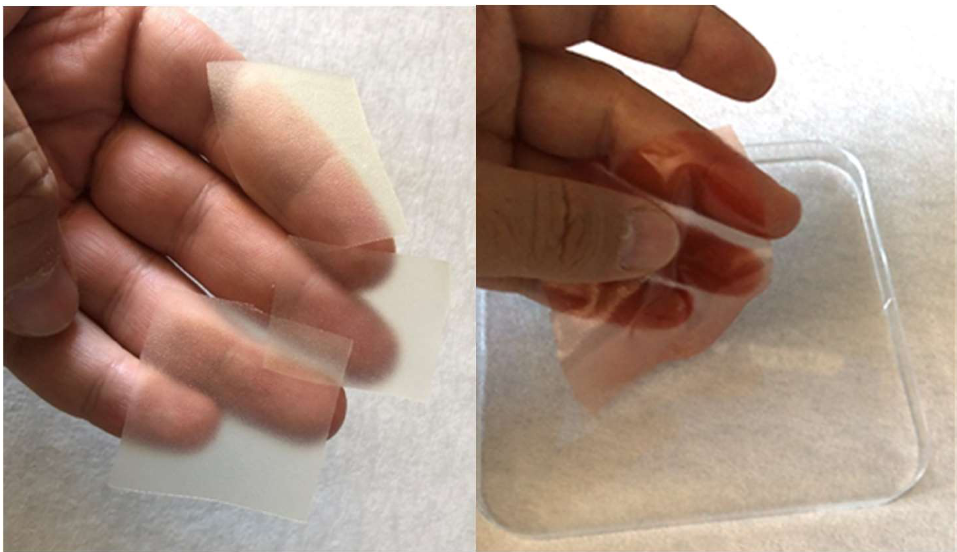
Figure 3. Blank OTFs ( left ), PG and MC included OTF ( right ).